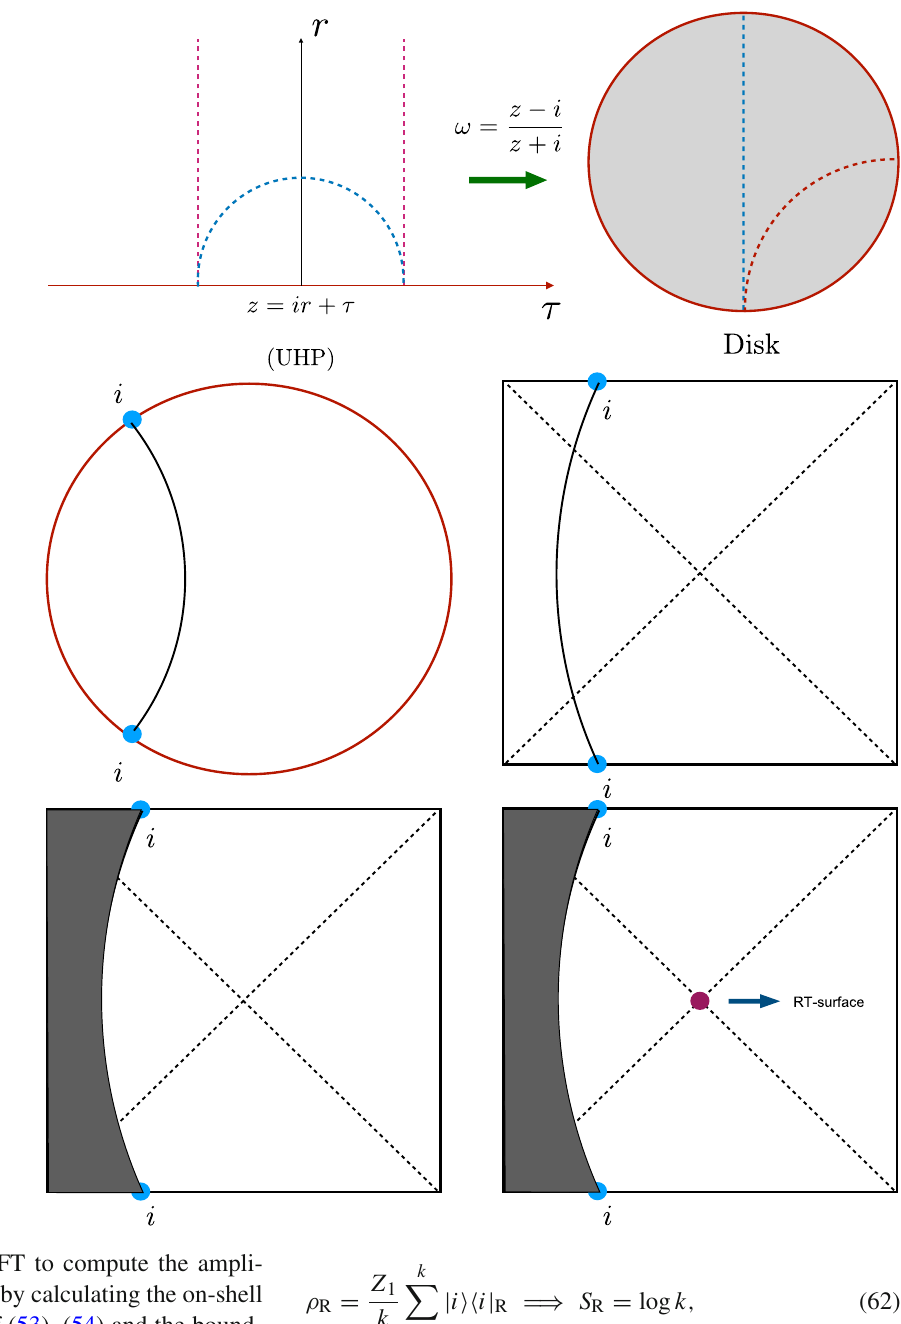
Fig. 5 The explicit map from the UHP to the unit Disk. With z = ir + τ , the ∂ Disk = S 1 is described by | ω | 2 = 1 ⇐⇒ r = 0. There are two kinds of geodesics on the UHP, described by the dashed blue semi-circles and the dashed pink vertical lines. These map to the dashed blue and the dashed pink geodesics on the Disk